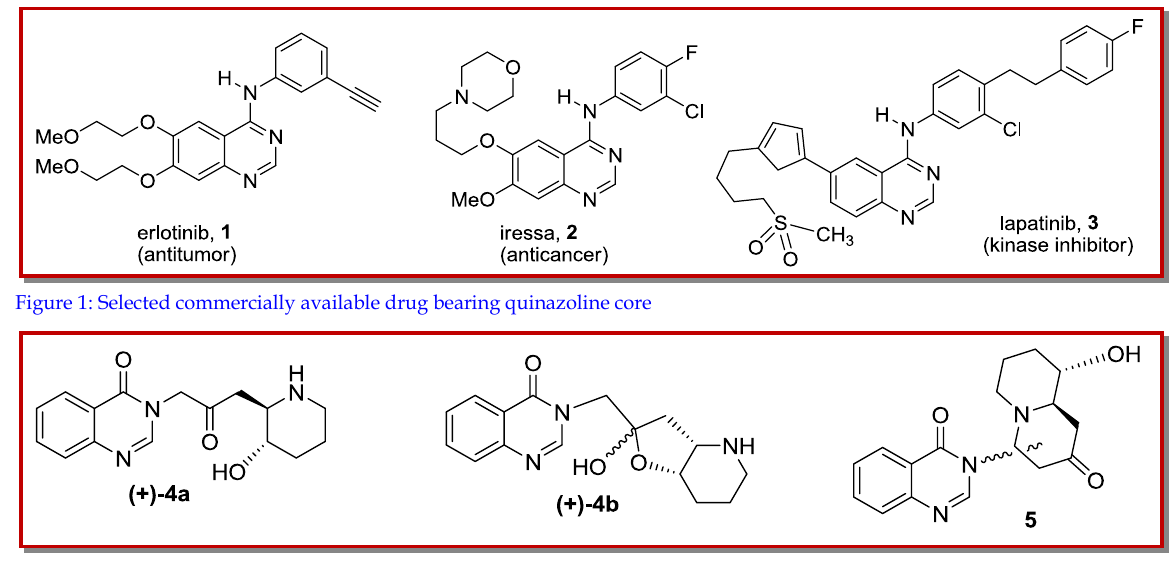
Figure 2: Structural identity of some naturally occurring quinazoline